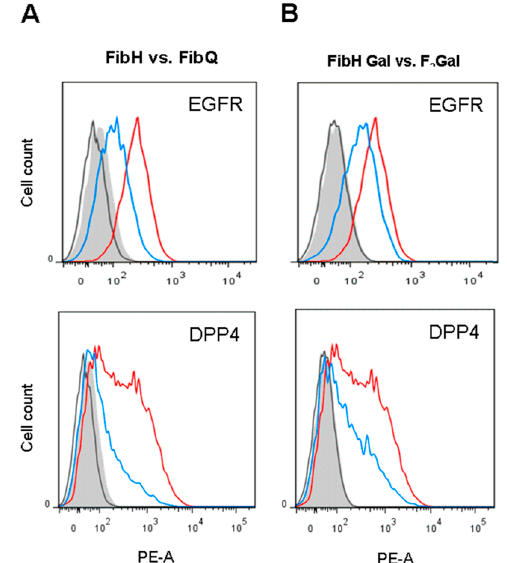
Figure 7. Fluorescence-activated cell sorting (FACS) experiments with galactosemic (FibQ, GM01704) and healthy control fibroblasts (FibH, GM05659) in the absence or presence of F 2 -Gal (1 g / L). ( A ) surface expression of EGFR and DPP4 on galactosemic (blue) and healthy control fibroblasts (red) in low-Glc / low-Gal medium; ( B ) surface expression of EGFR and DPP4 on healthy control fibroblasts in the absence (red) and presence of 0.1% F 2 -Gal (blue) in low-Glc / low-Gal